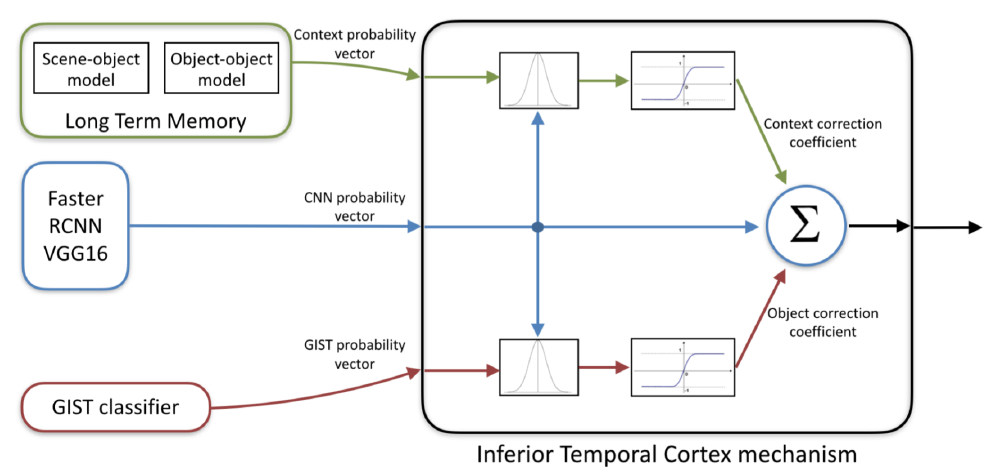
Figure 5. Illustration of the inferior temporal cortex (ITC) mechanism in the VAP